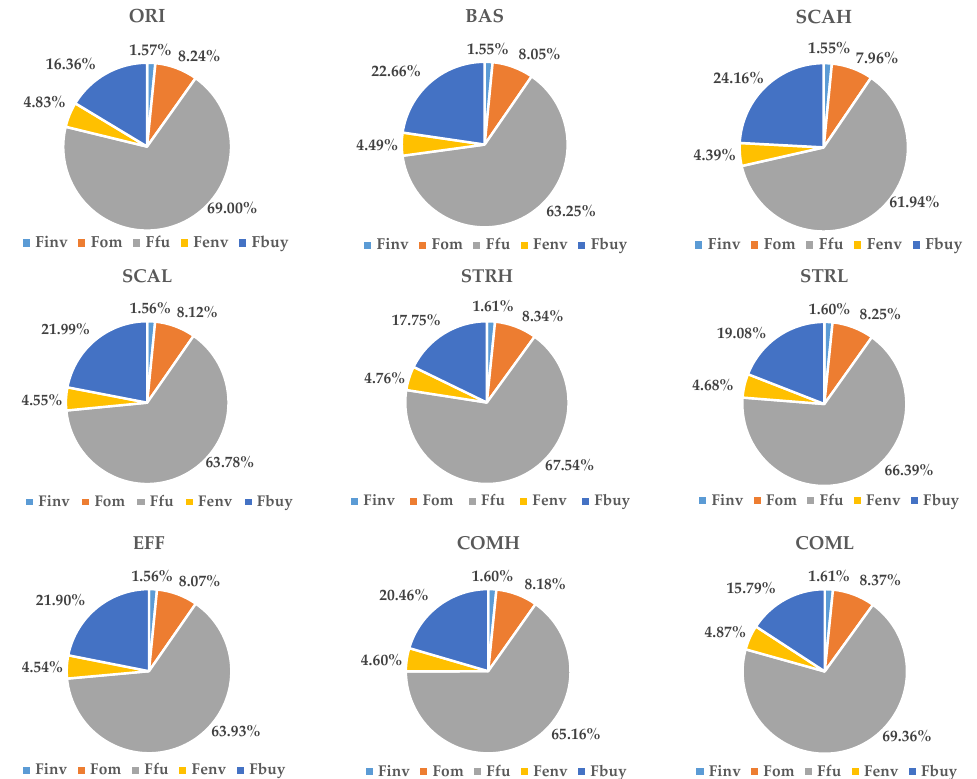
Figure 7. Proportions of various costs under different scenarios.